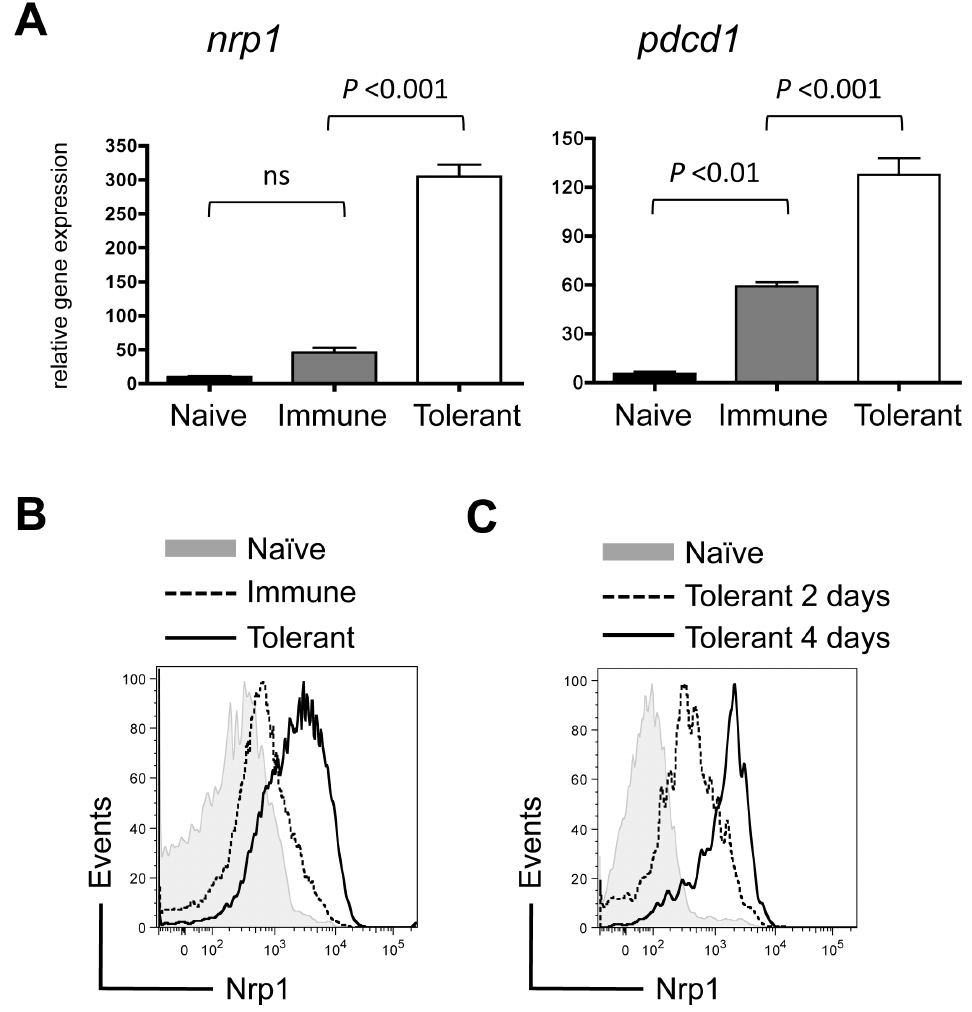
Figure 1. Nrp1 is highly expressed on tolerant CD8 + T cells primed by a self-antigen in healthy liver. Naive Gag-specific CD8 + T cells (CD90.1 + ) were transferred into B6 mice (naive), B6 mice bearing an immunogenic FBL tumor (immune), Alb:Gag mice (tolerant). (A) Two days after transfer, T cells were purified by cell sorting and RNA isolated for gene expression by microarray. Graphs displays nrp1 and pdcd1 relative gene expression pooled from biological triplicate samples, and error bars represent SD. (B) Nrp1 protein expression on T cells 3 days after adoptive transfer into the naive, immune or tolerant environment. Data are representative of 3 experiments, each with 3 recipient mice per group. (C) Nrp1 protein upregulation on T cells 2 and 4 days after transfer into Alb:Gag recipients. Data are representative of 2 time course